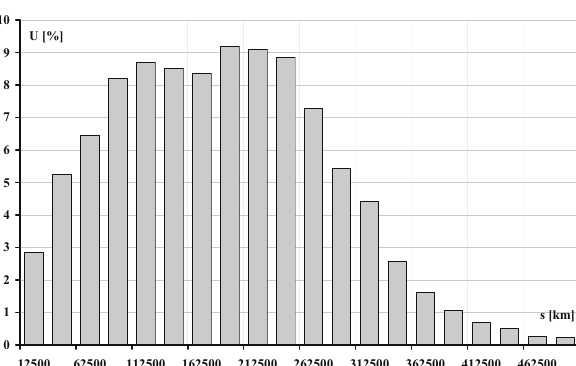
Figure 1: Histogram of road mileages of tested vehicles.